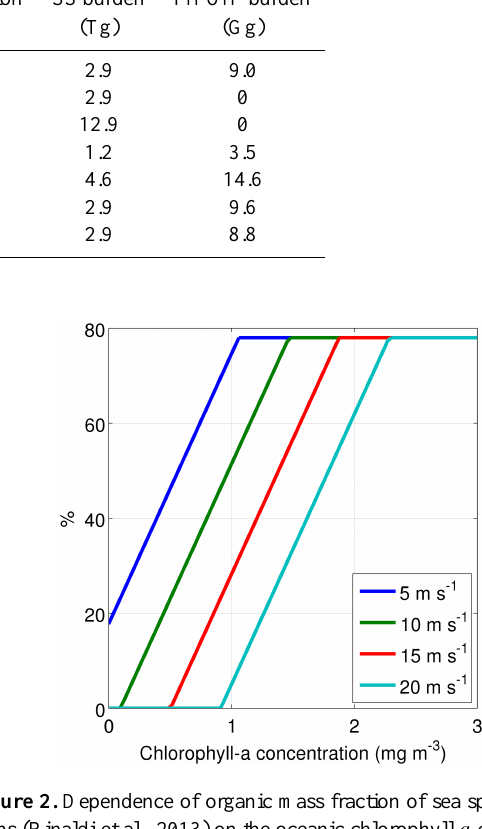
Table 5. Global total sea spray aerosol emissions and burdens in the model runs. Here SS refers to sea salt and PMOM to primary marine organic matter. Model run